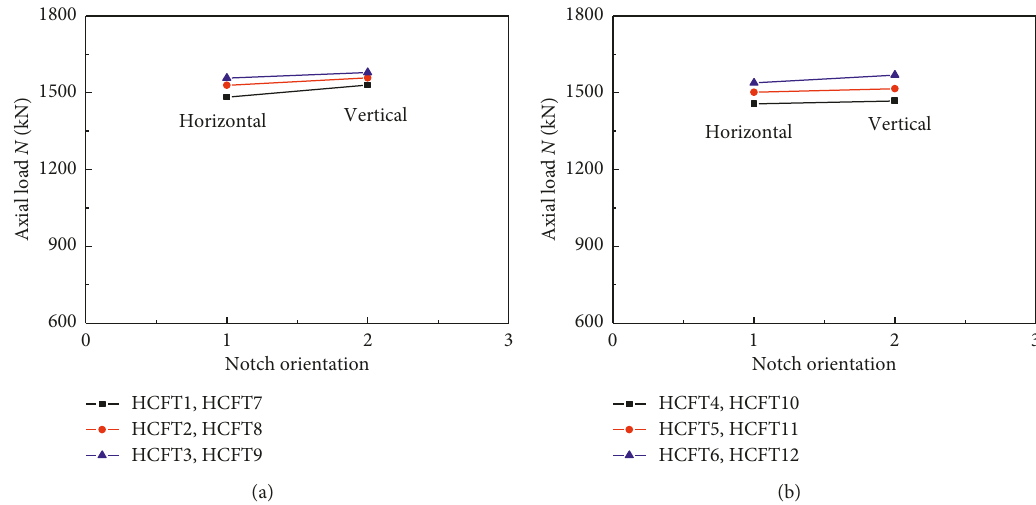
Figure 9: Influence of notch orientation on the ultimate strength of specimens. (a) Sideway notch (HCFT1 ∼ HCFT6). (b) Corner notch (HCFT7 ∼